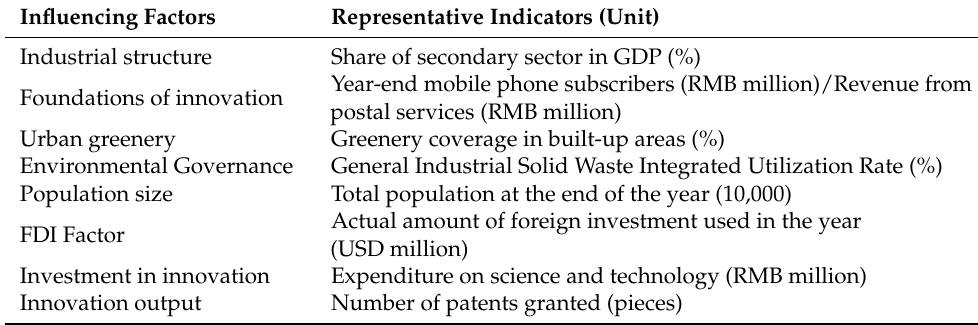
Table 1. Factors influencing location selection of water pollution in the YRD.